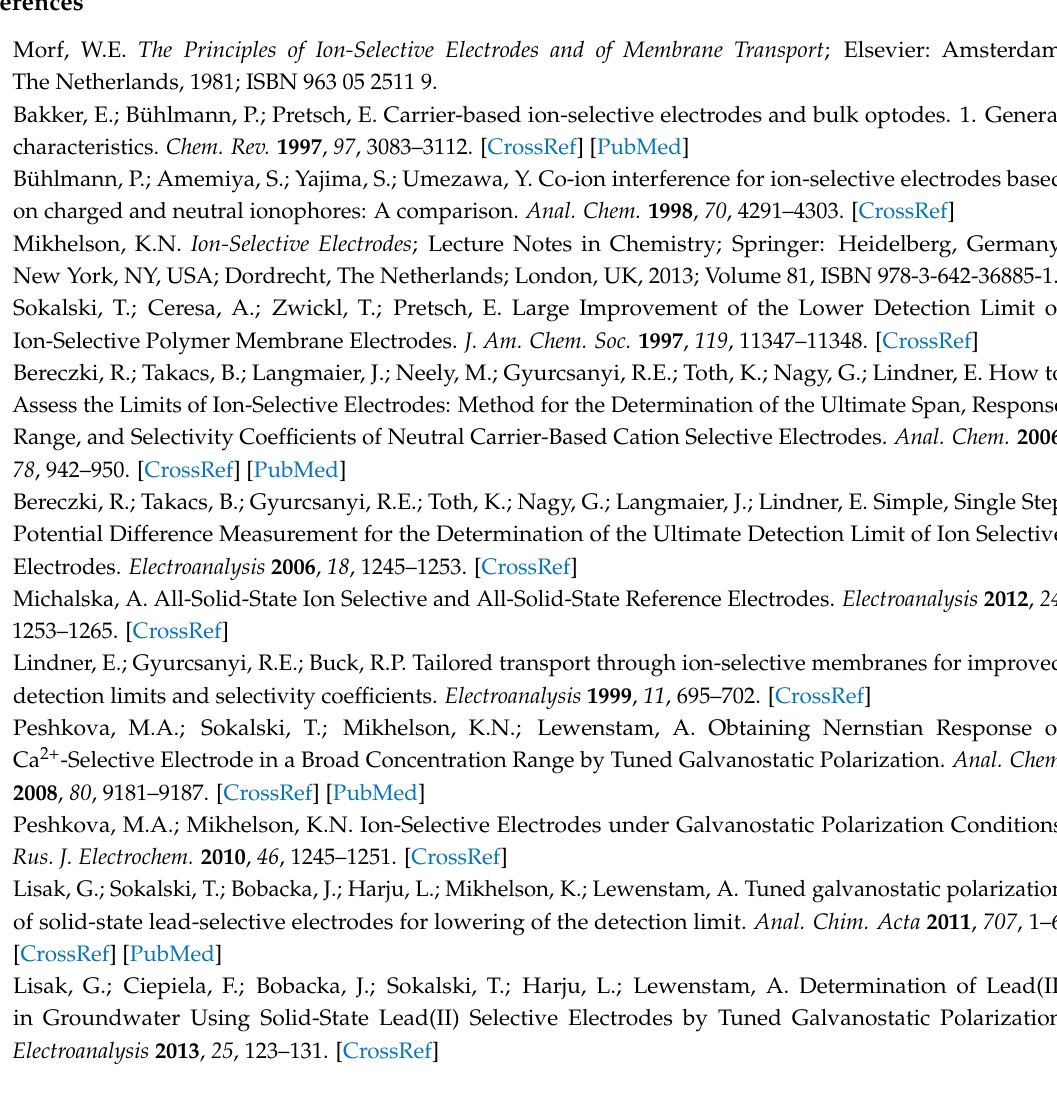
s1, Figure S1: The electrode design; Figure S2: Changes of the impedance spectrum of ISE 2 in contact with 0.001 M KNO 3 solution during soaking; Figure S3: ISEs response curves over the sequential 10-fold dilution of 0.1 M KNO 3 with DI water. The curves obtained with ISEs aged two months, when all chronopotentiometric and impedance studies were over; Figure S4: ISEs calibration curves over the sequential 10-fold dilution of 0.1 M KNO 3 with DI water. The curves obtained with ISEs aged two months, when all chronopotentiometric and impedance studies were over. Straight line refers to ISE 1; Table S1: Electrochemical properties of the ISEs under